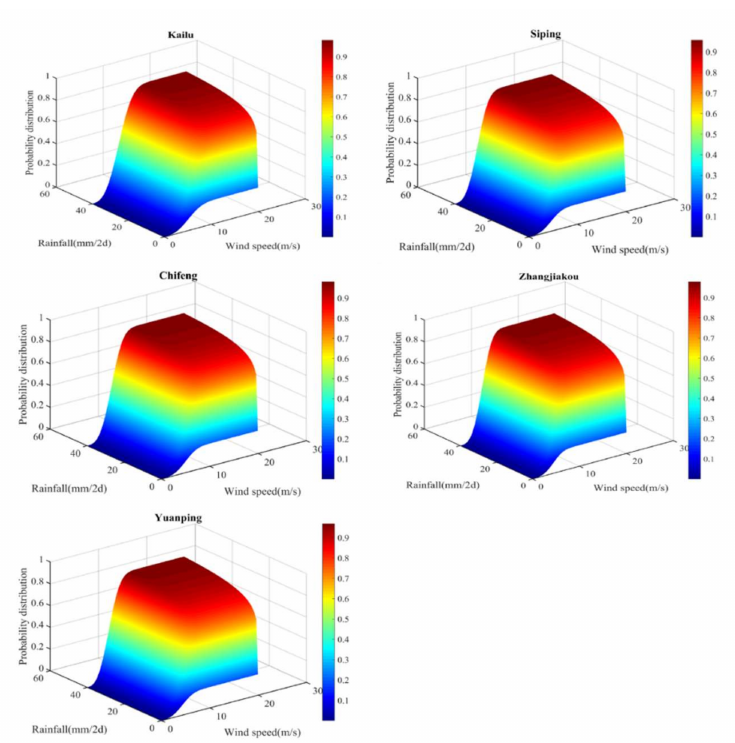
Figure 6. Joint probability distribution of wind and rain.